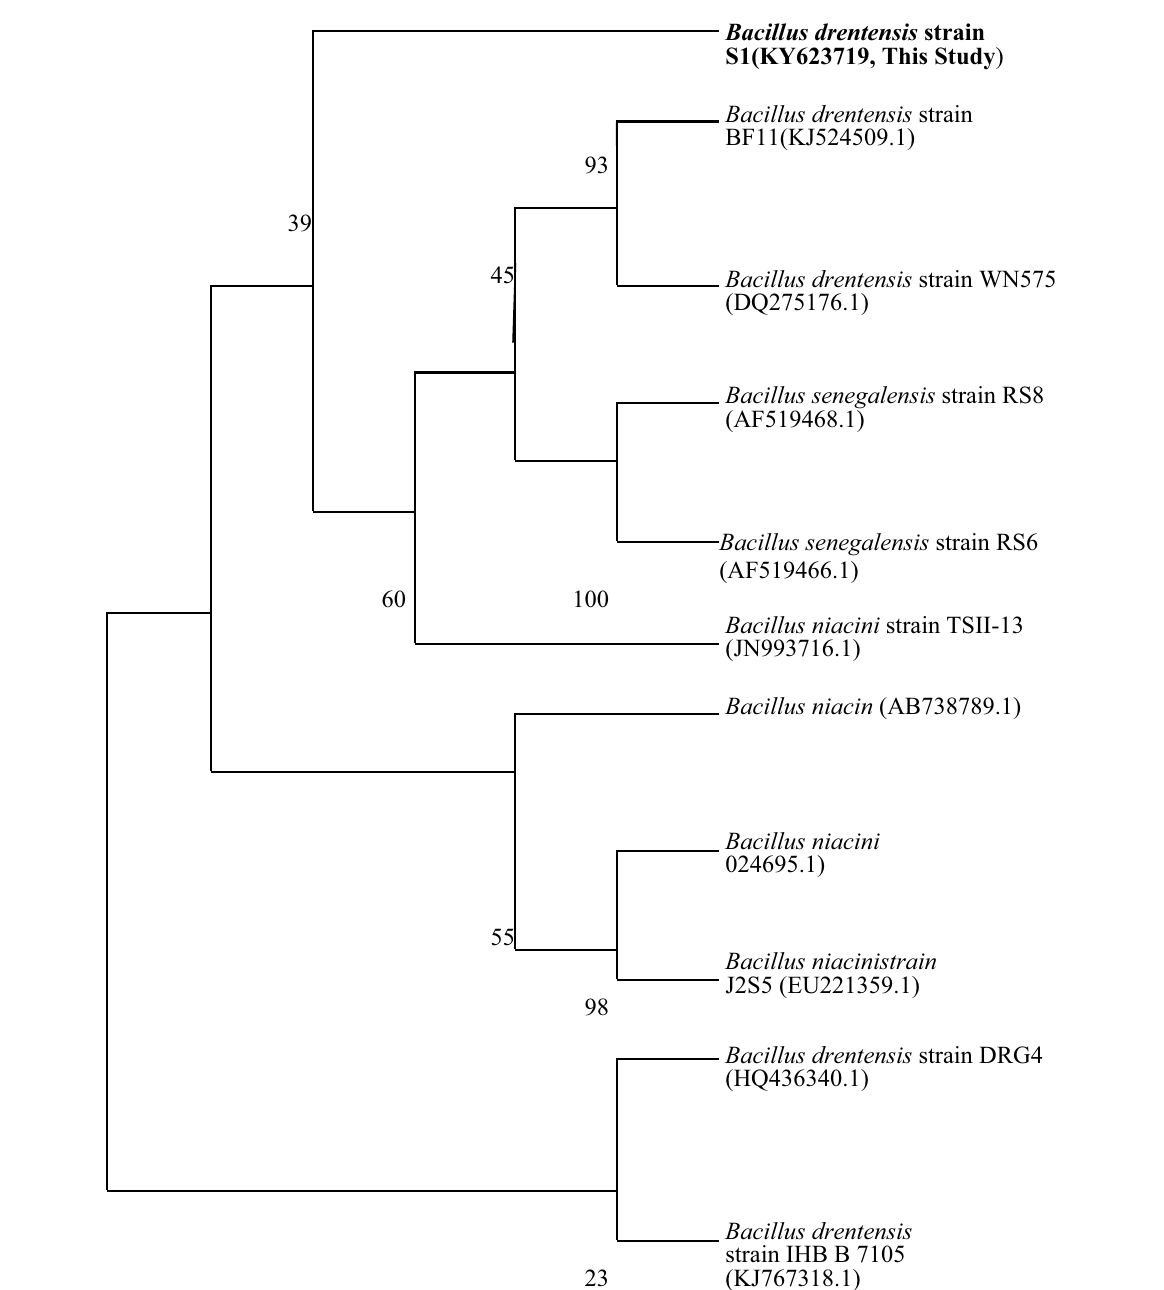
Fig. 3 The maximum likelihood phylogenetic showing the position of APAP-degrading Bacillus drentensis strain S1 (KY623719) relevant to other type strains with genus